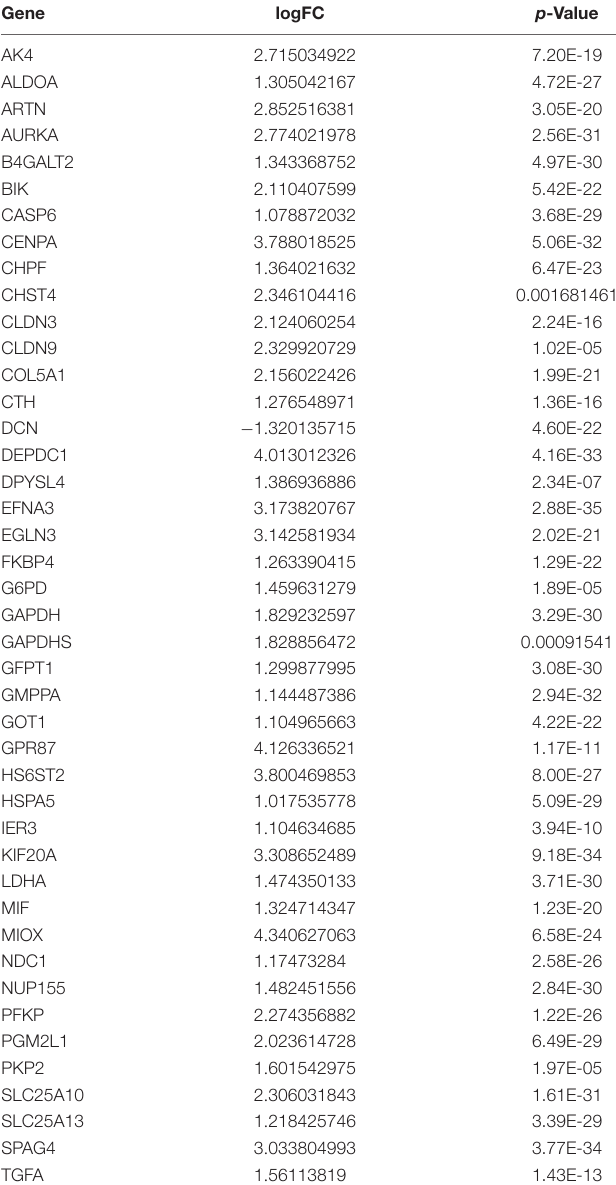
TABLE 1 | Differentially expressed 43 glycolysis-related genes in lung